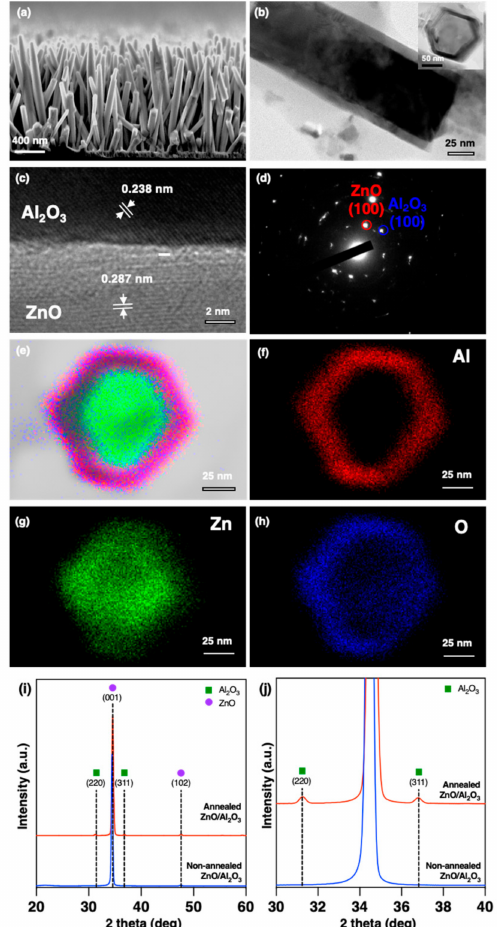
Figure 3. Characterization of ZnO/Al 2 O 3 core-shell nanowires with postannealing treatment process. ( a ) SEM image and ( b ) TEM of ZnO/Al 2 O 3 core-shell nanowire. Inset in Figure 3b is